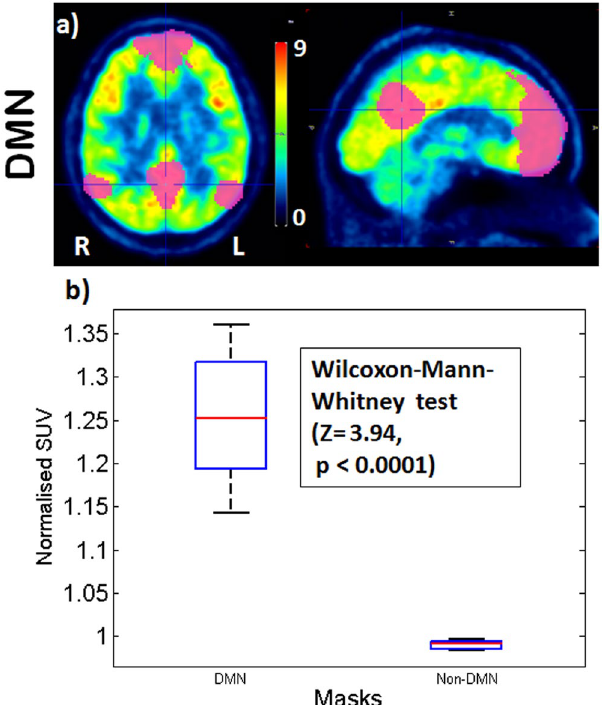
Figure 6. SUV of FDG within the DMN mask and Non-DMN. ( a ) Resting state FDG PET SUV image of an exemplary subject with DMN mask identified by ICA (upper row). ( b ) The box plot shows the normalised SUV of FDG within the DMN mask and the non-DMN mask for 11